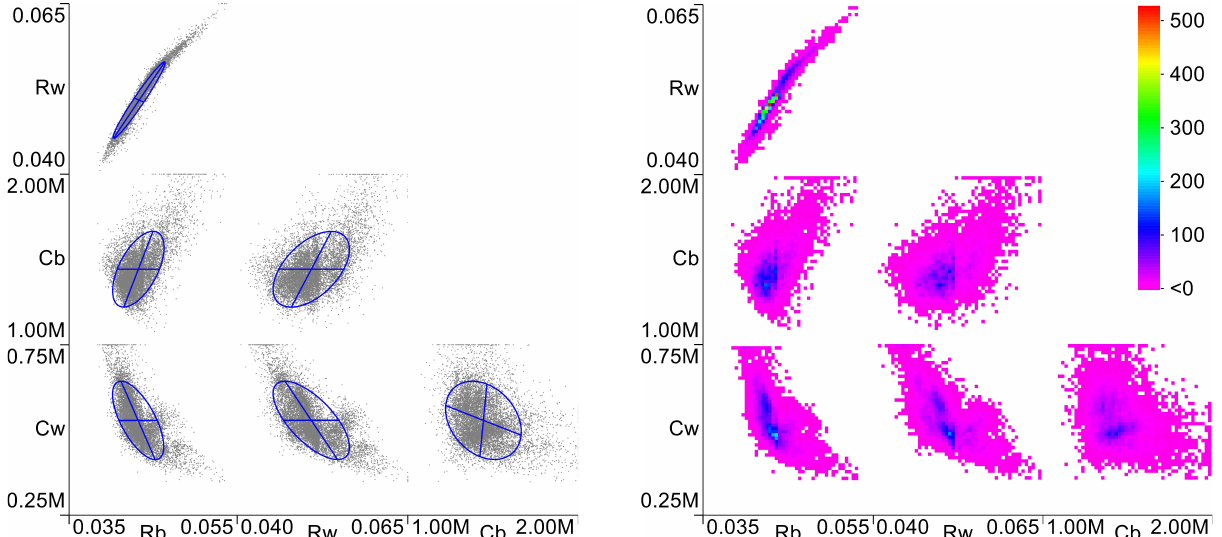
Figure 24: Bootstrap results for the R2C2 model, with M = 10 . 000 iterations represented as scatter plots with 95% confidence ellipses, simultaneous for the projected parameters, for the mean estimate (left) and corresponding 2D histograms (right). Both the scatter plots and the histograms are presented as two-dimensional projections onto each possible parameter combination plane Θ i,j .